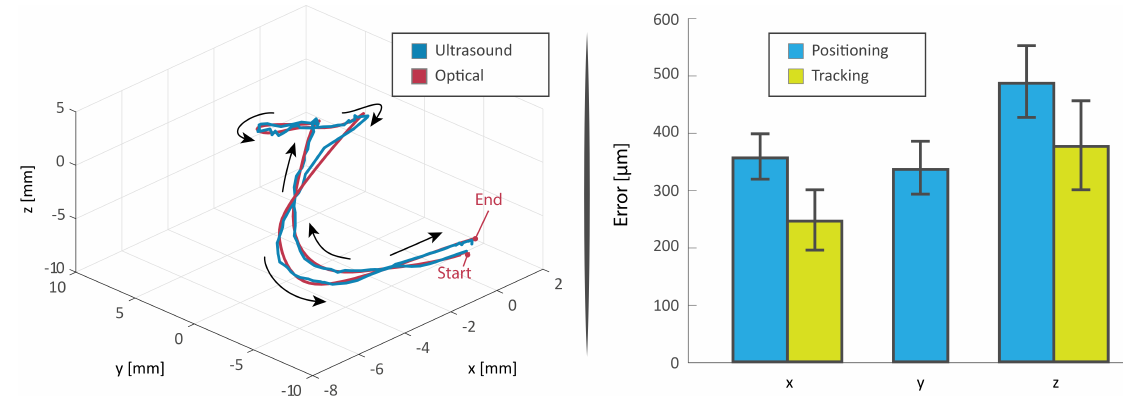
Figure 6. ( Left ) Representative example of the trajectory followed by a microrobot through the experiments. The blue curve shows the ultrasound tracking results. The red curve represent the same trajectory as computed offline by an optical tracker [10]. ( Right ) Histogram of the positioning and tracking errors over the performed ten trials. The positioning error (blue) is defined as the divergence between the filtered reference and the state as tracked by the ultrasound tracking system; i.e., the error as computed in the control loop. Conversely, the tracking error (yellow) is defined as the difference in tracked position between the ultrasound and optical (computed offline) tracker. Consequently, we can only compute the tracking error for x and z components. However, for reasons of symmetry, we expect the y component, which cannot be analyzed optically, to have similar tracking error to that of the x